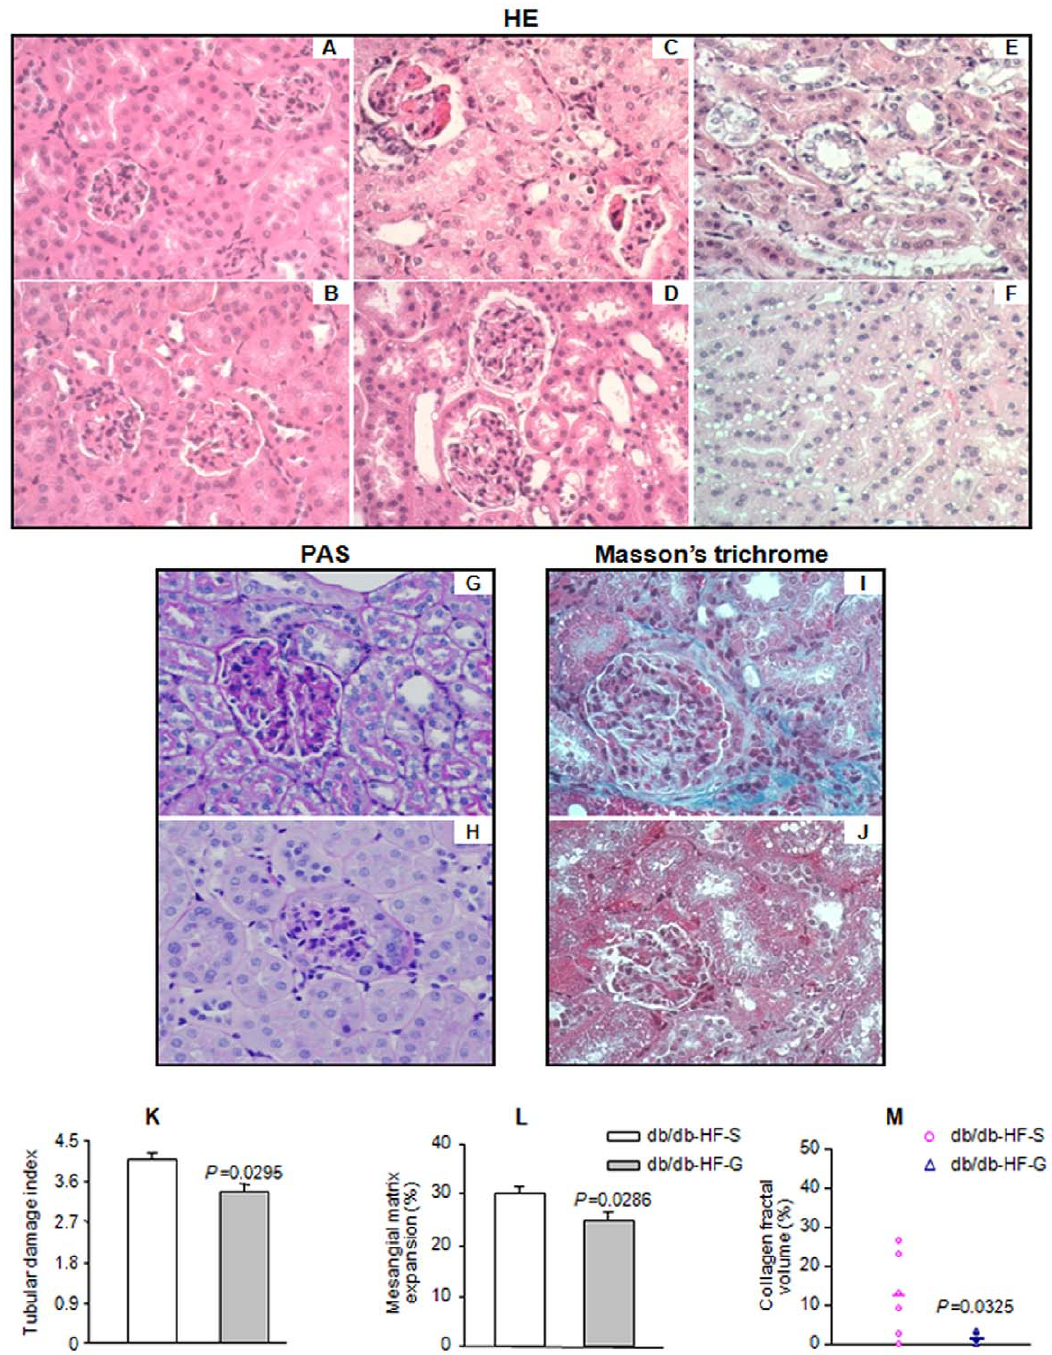
Figure 2. Kidney histopathology of HFD-fed db/db mice. Representative figures showing the photomicrographs of HE ( A–F ), PAS ( G , H ), and Masson’s trichrome stained sections from db/db-HF-S group ( C, E, G, I ) and db/db-HF-G group ( D, F, H, J ) taken at 200 6 magnification. Image-based computer assisted analysis was performed to quantify tubular damage index ( K ), mesangial expansion ( L ), and interstitial collagen accumulation ( M ) from 6 animals per group. (A) and (B) showed parallel experiments with HFD-fed db/ + mice injected with saline and 17-DMAG,